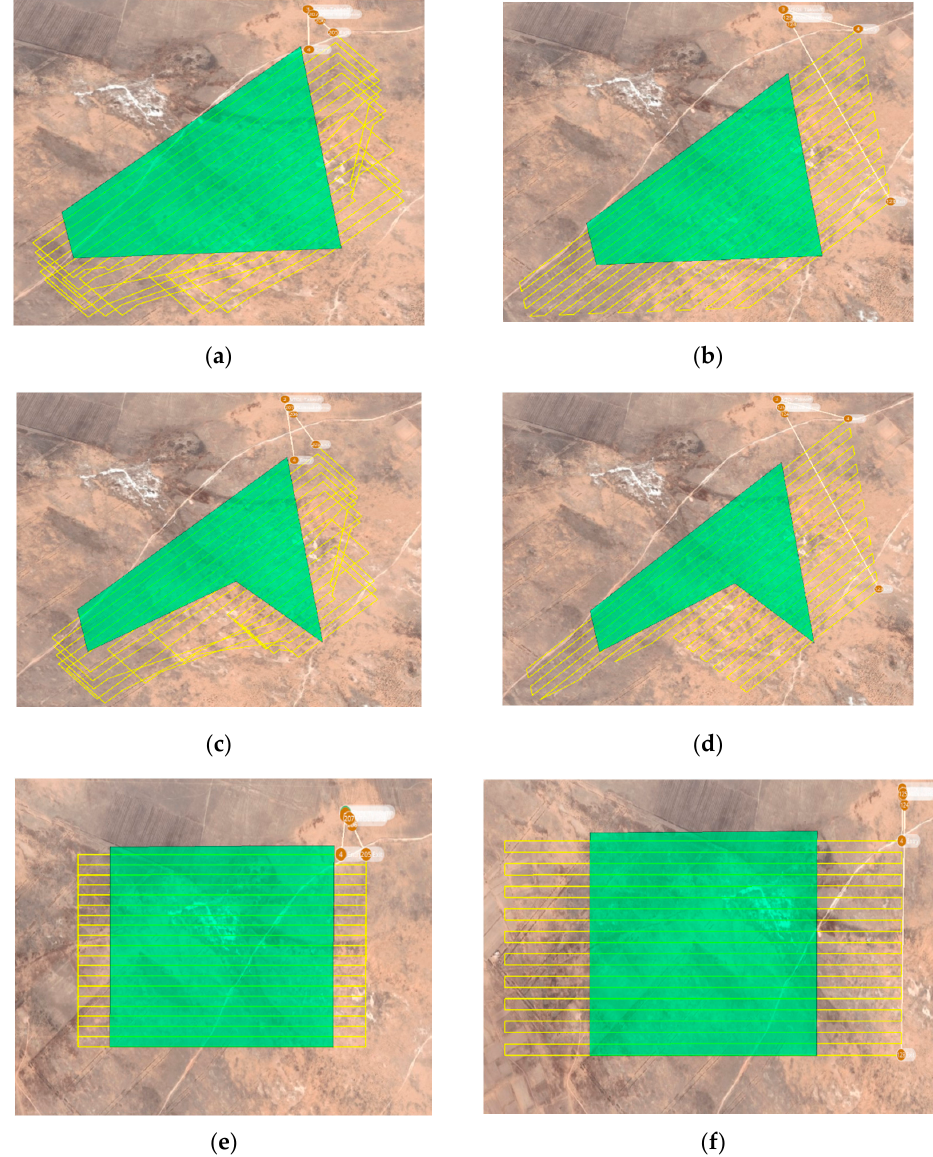
Figure 10. Path planning of different area shapes. ( a ) Convex polygon Area coverage using GPSA-GA, ( b ) Convex polygon Area coverage using Scan-type, ( c ) Concave polygon Area coverage using GPSA-GA, ( d ) Concave polygon Area coverage using Scan-type, ( e ) Rectangular area coverage using GPSA-GA, ( f ) Rectangular area coverage using Scan-type.